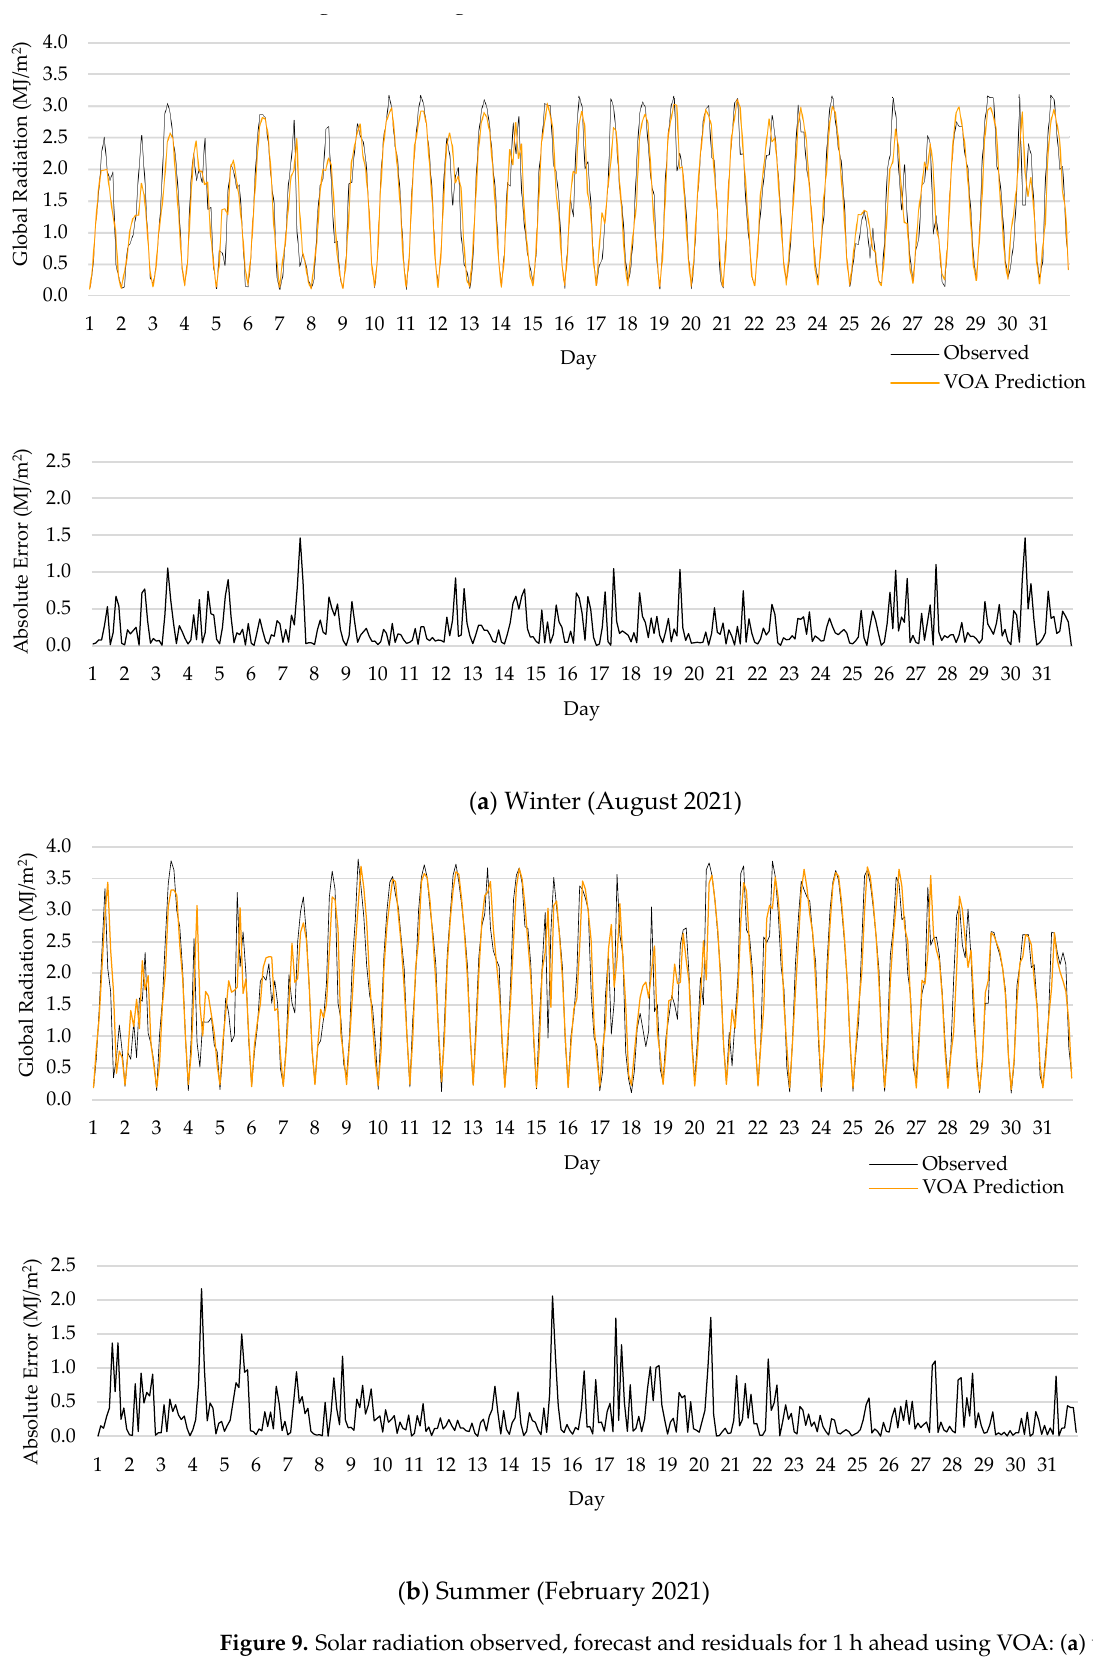
Figure 9. Solar radiation observed, forecast and residuals for 1 h ahead using VOA: ( a ) winter and ( b ) summer.